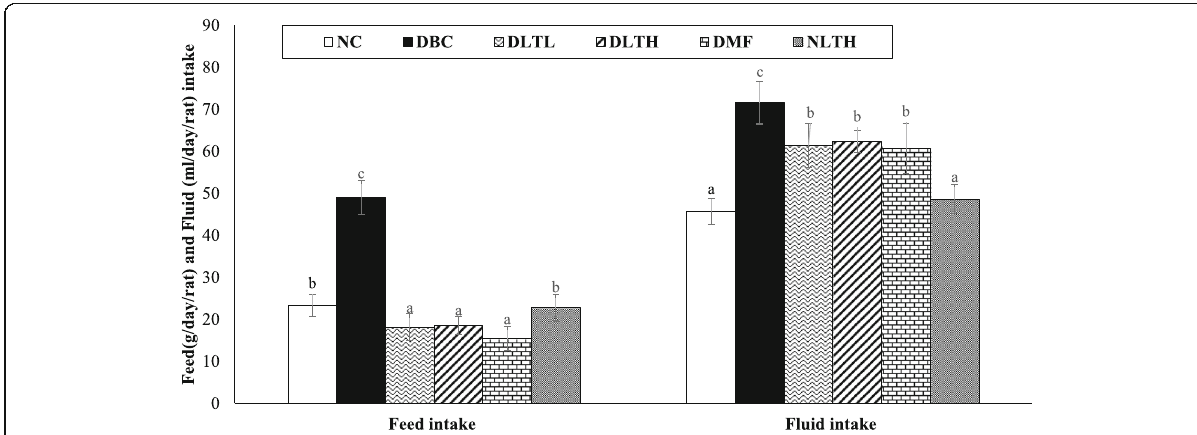
Fig. 1 Feed and fluid intake in different animal groups during the experimental period. Data are presented as the mean ± SD of 7 animals. a – c Values with different letters over the bars for a given parameter are significantly different from each other group of animals (Tukey ’ s-HSD multiple range post hoc test, p < 0.05). NC- Normal control; DBC- Diabetic control; DLTL- Diabetic lemongrass tea low; DLTH- Diabetic lemongrass tea high; DMF- Diabetic metformin; NLTH- Normal lemongrass tea